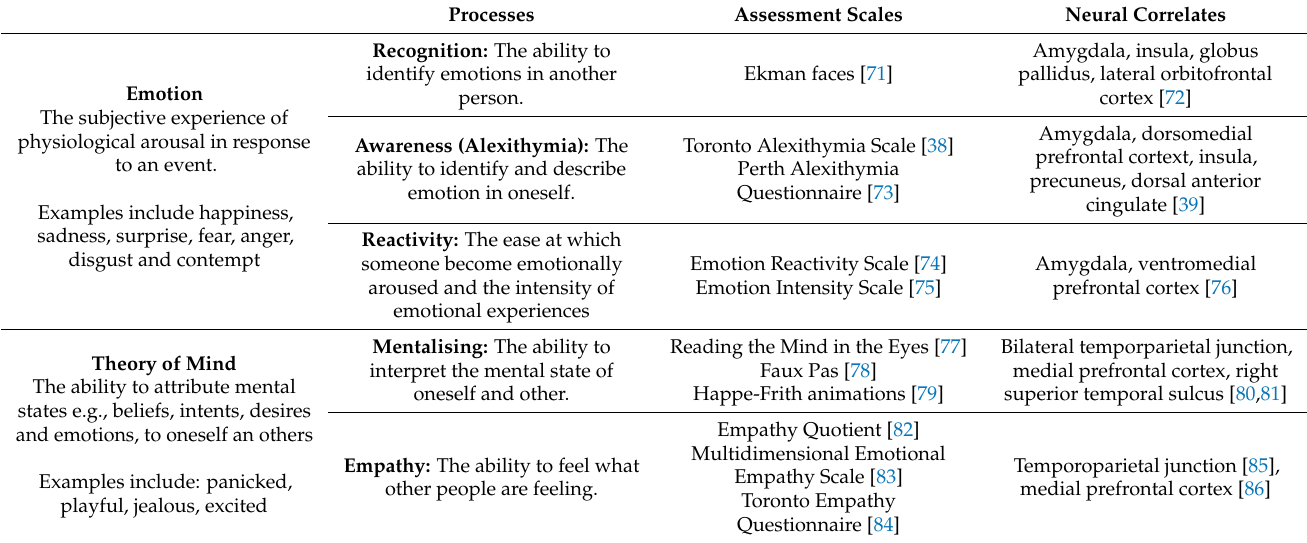
Table 1. Social cognition: processes relevant to Huntington’s disease. Processes Assessment Scales Neural